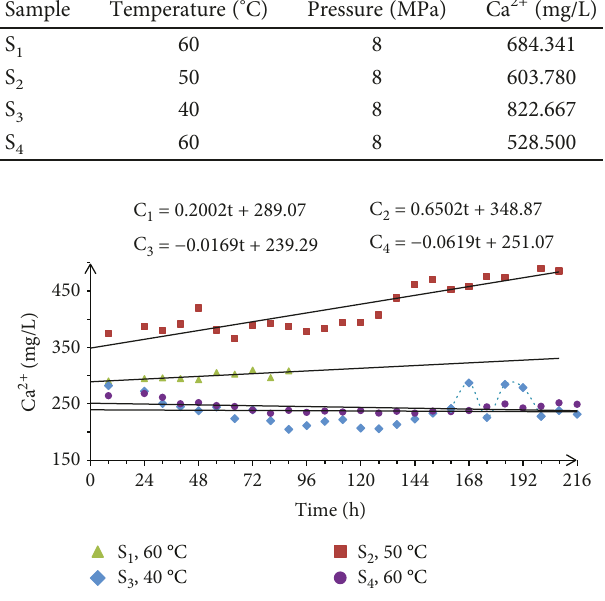
over time. The dotted line data eq